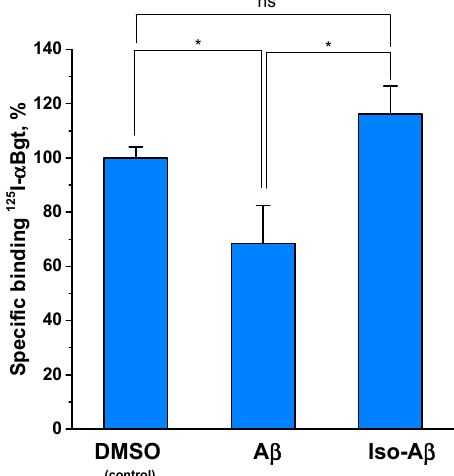
Figure 2. Specific binding of 125 I- α Bgt to Neuro2a cells transiently transfected with human α 7nAChR. The cells were pre-incubated for 72 h with either 0.4% DMSO (control) or 10 µ M of A β 42 or iso-A β 42 dissolved in DMSO. Specific binding in the control is set to 100%. Data are presented as the mean ± SEM of two independent experiments with at least five replicates for each point. * p < 0.05, ns = non- significant.